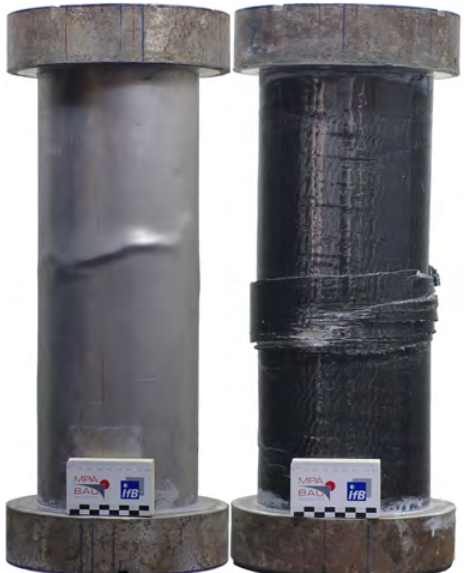
Figure 6. Series A specimen 3 (left) and Series B specimen 1 (right) after testing